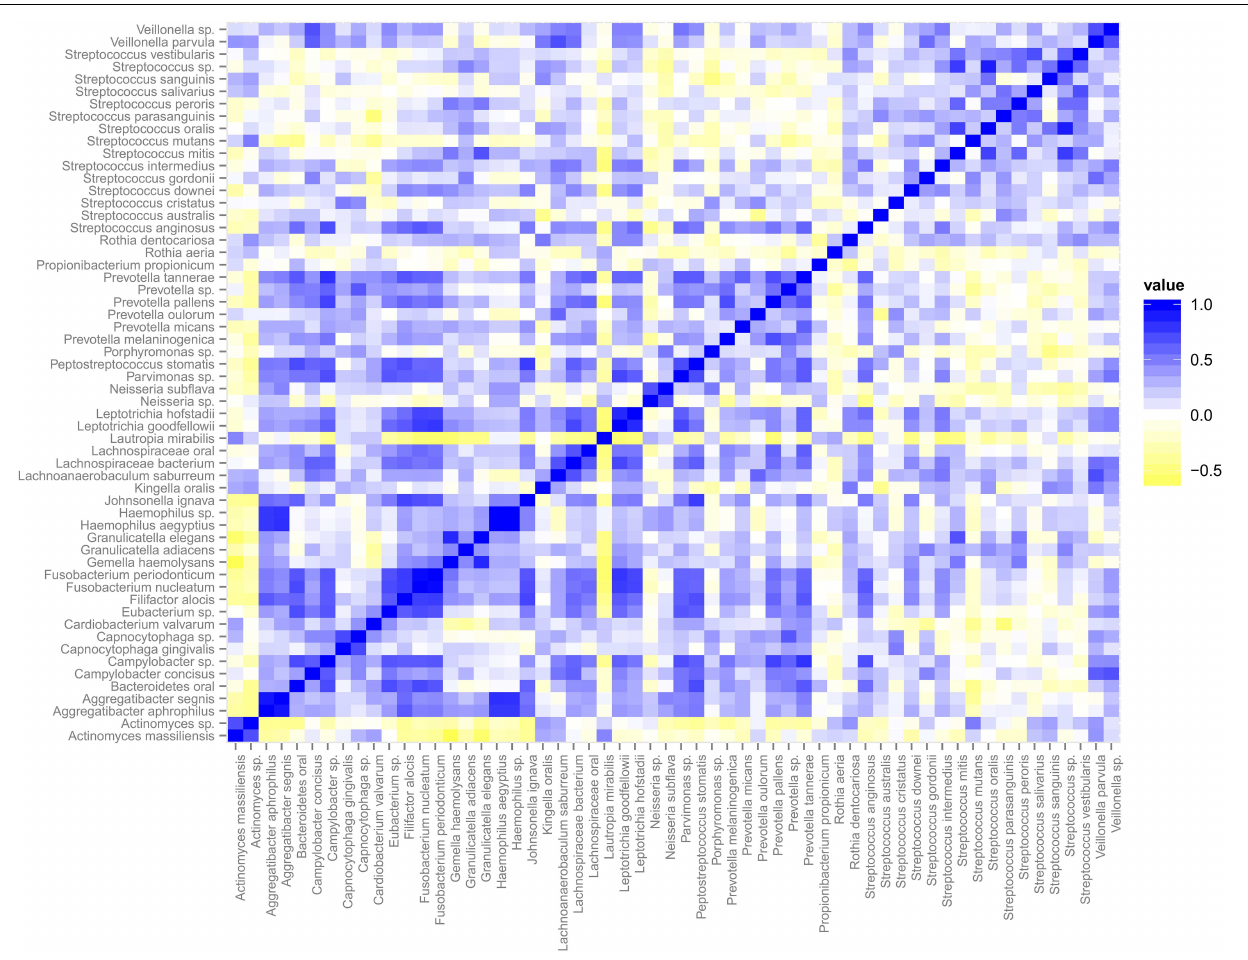
FIGURE 4 | Spearman Correlation matrix of the dental plaque core microbiota. Blue indicates positive correlation and yellow indicates negative correlation.